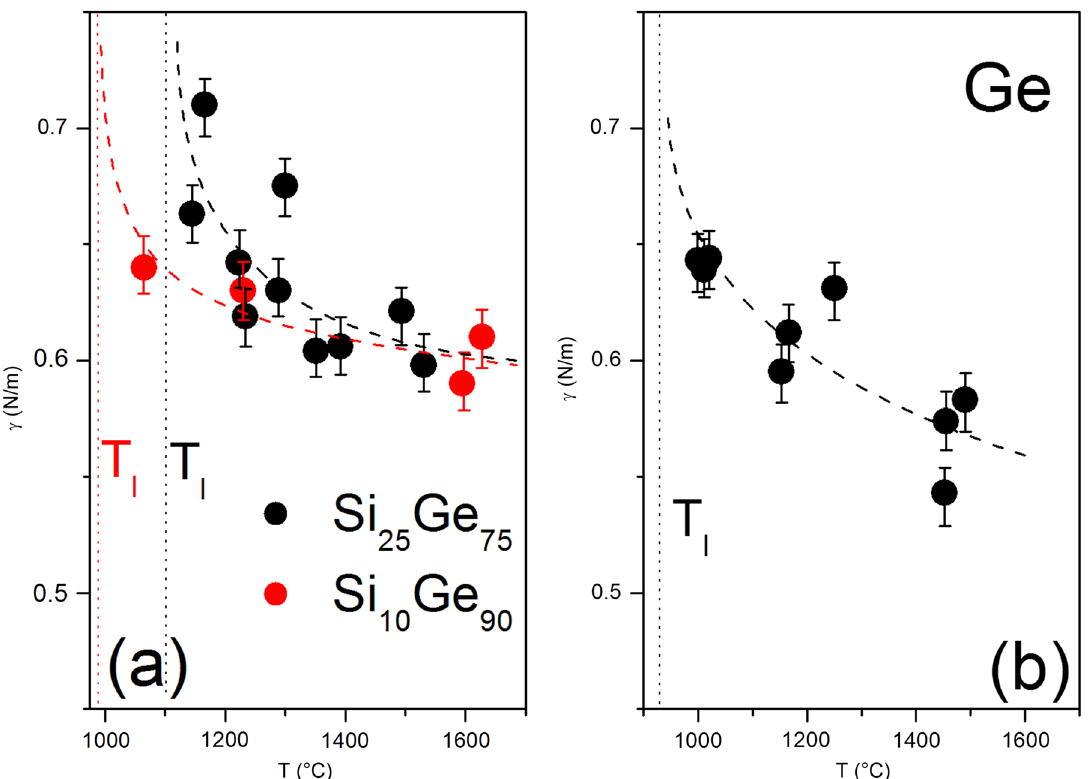
Fig. 7 Temperature-dependent surface tension γ measured a for Si 10 Ge 90 and Si 25 Ge 75 and b for the pure Ge (the dashed lines only serve as a guide for the eye)